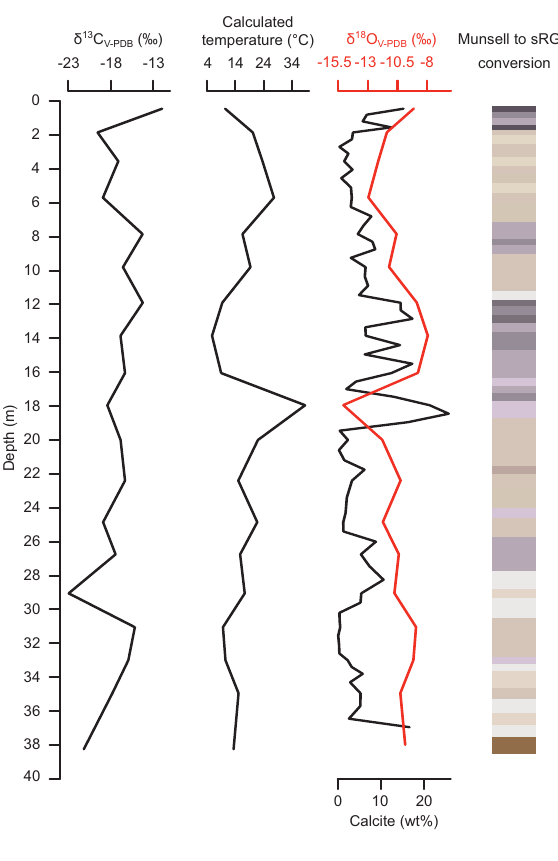
Fig. 3. Calculated equilibrium temperatures and Munsell colour­ ation of samples compared to isotopic